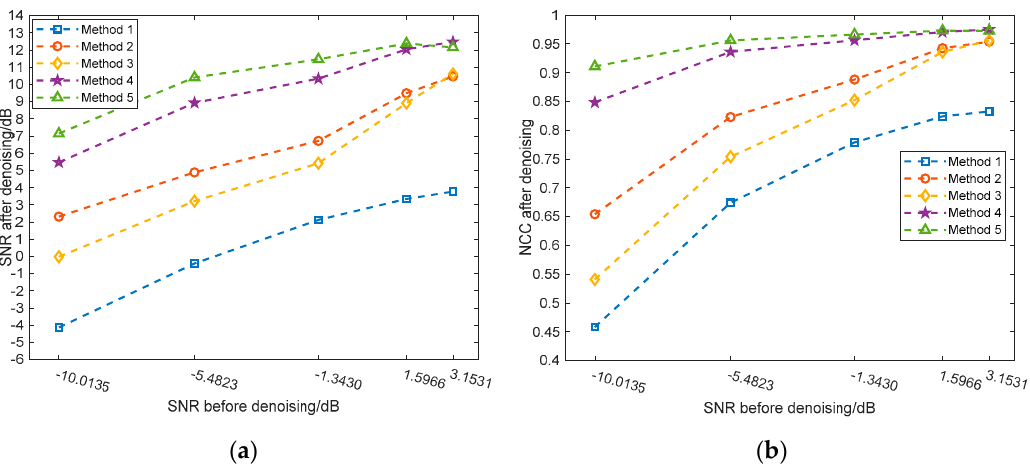
Figure 10. Quantitative results by different algorithm under various SNR levels: ( a ) SNR results; ( b ) NCC results.